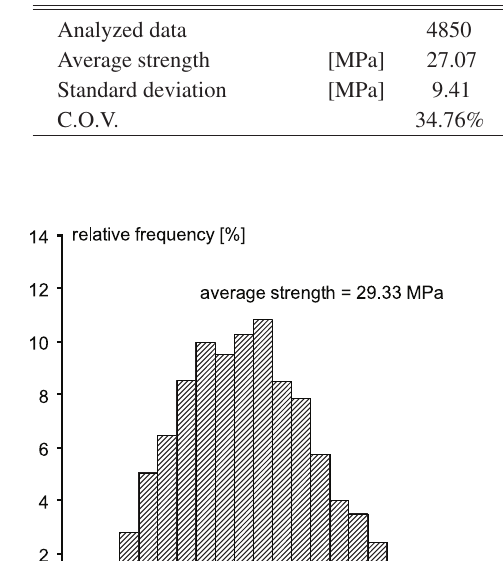
Table I. Strength distribution of concrete in the year